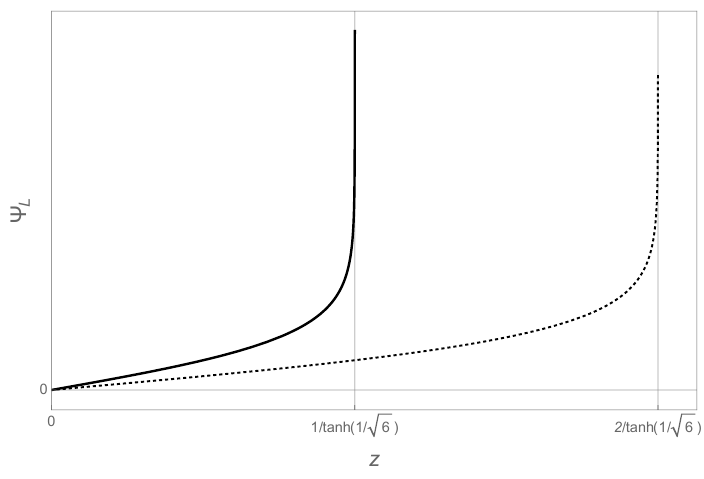
Figure 1 . The value of the running coupling (cid:9) L ( z ) as a function of the inverse energy scale z . The two lines represent on-shell renormalization schemes with (cid:9) L ( L ) = 1 with L = 1 (solid line) and L = 2 (dotted